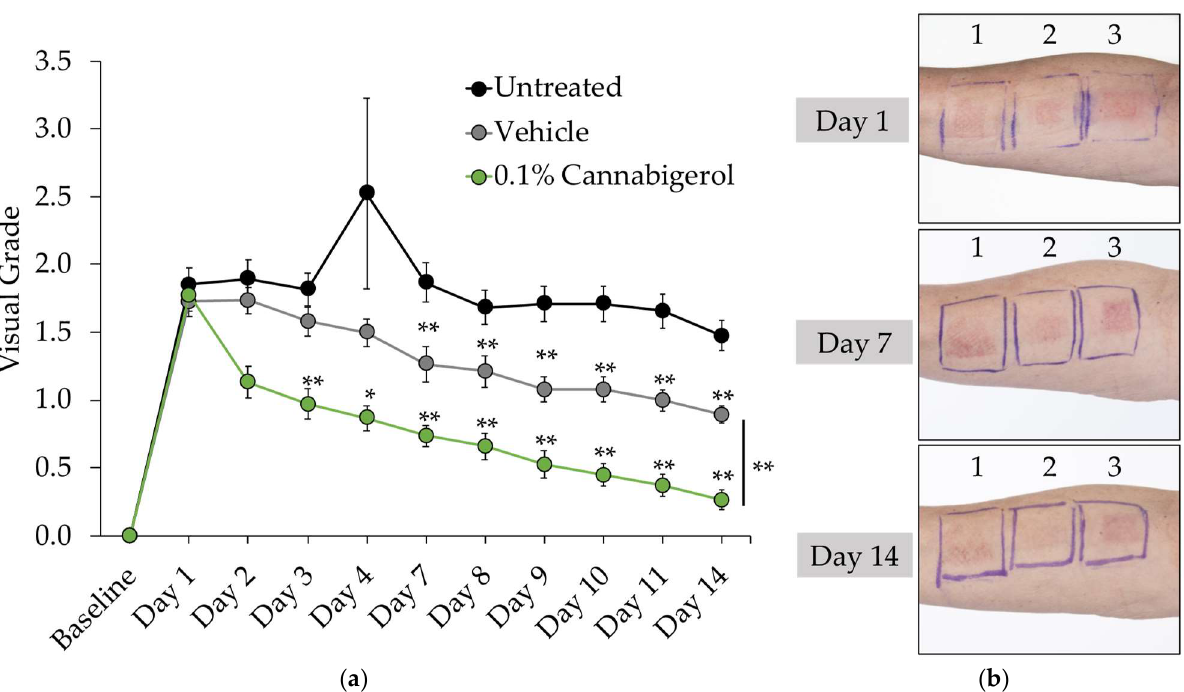
Figure 4. Skin irritancy was improved by 0.1% CBG in serum formulation as measured by visual grading. ( a ) Visual grade data represent mean ± SEM from 20 participants from each group. * p < 0.05; ** p ≤ 0.01 indicates a statistically significant difference compared to untreated group. ( b ) Photographs of a representative subject on day 1, 7, and 14 of the study where patch 1 = Untreated; 2 = 0.1% CBG; and 3 = Vehicle (placebo).